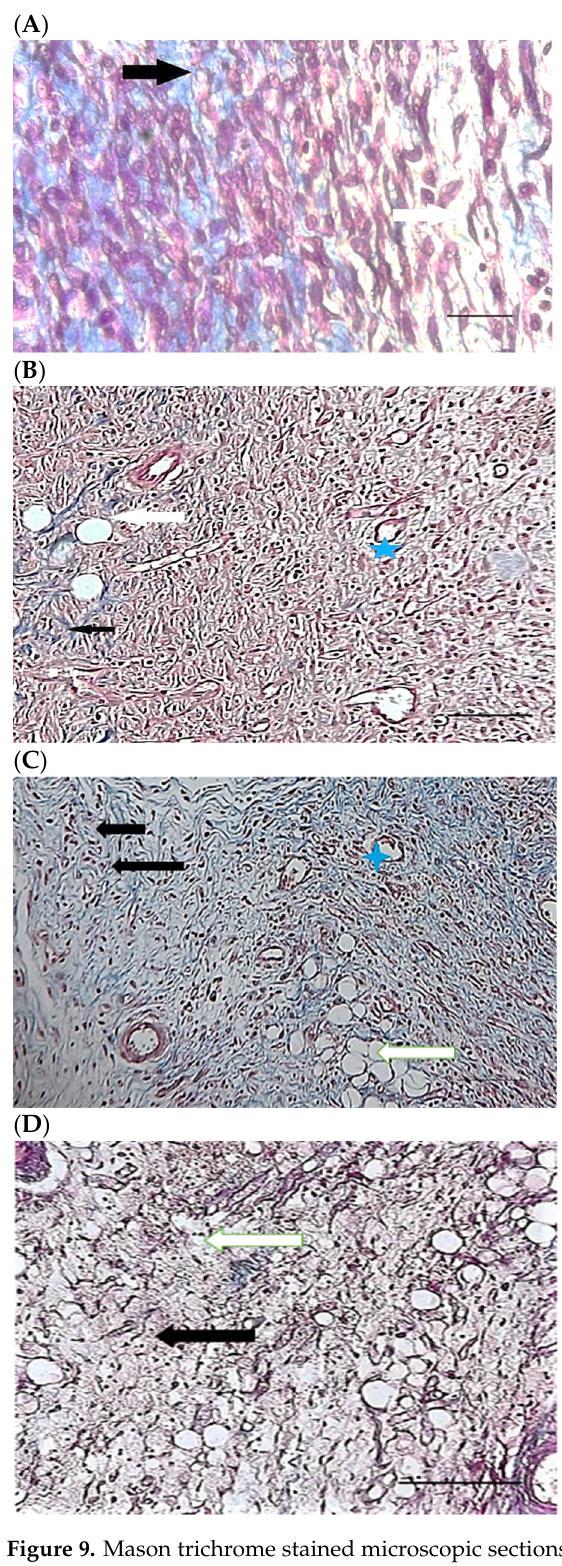
Figure 9. Mason trichrome stained microscopic sections (Bar = 100μm) wound in rats on day 7 of the study. ( A ) Control group; edema (white edema), scattered and thin collagen fibers (black arrow). ( B ) Ch group; Collagen fibers (black arrow), edema (white arrow), newly formed vessels (blue star). ( C ) ChSeN group; edema (white edema), collagen fibers (black arrow), hyperemia (blue star). ( D ) ChSeND group; edema (white arrow), collagen fibers (black arrow).